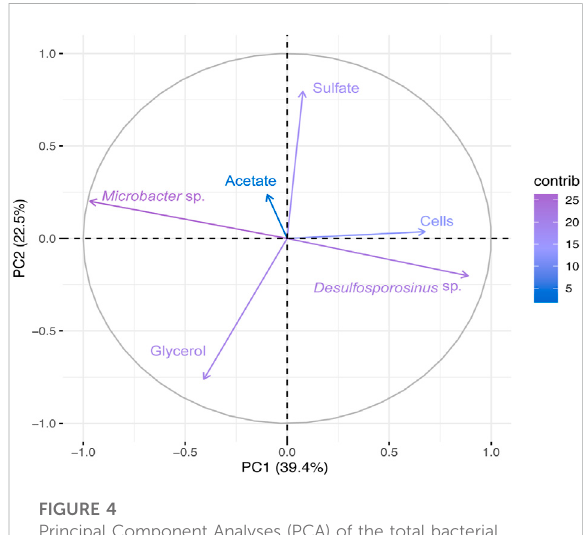
FIGURE 4 Principal Component Analyses (PCA) of the total bacterial community based on 16S rRNA gene sequences and physical- chemical analysis data from Bio II. First principal coordinates (PC1 39.4%) and the second principal coordinates (PC2 22.5%).